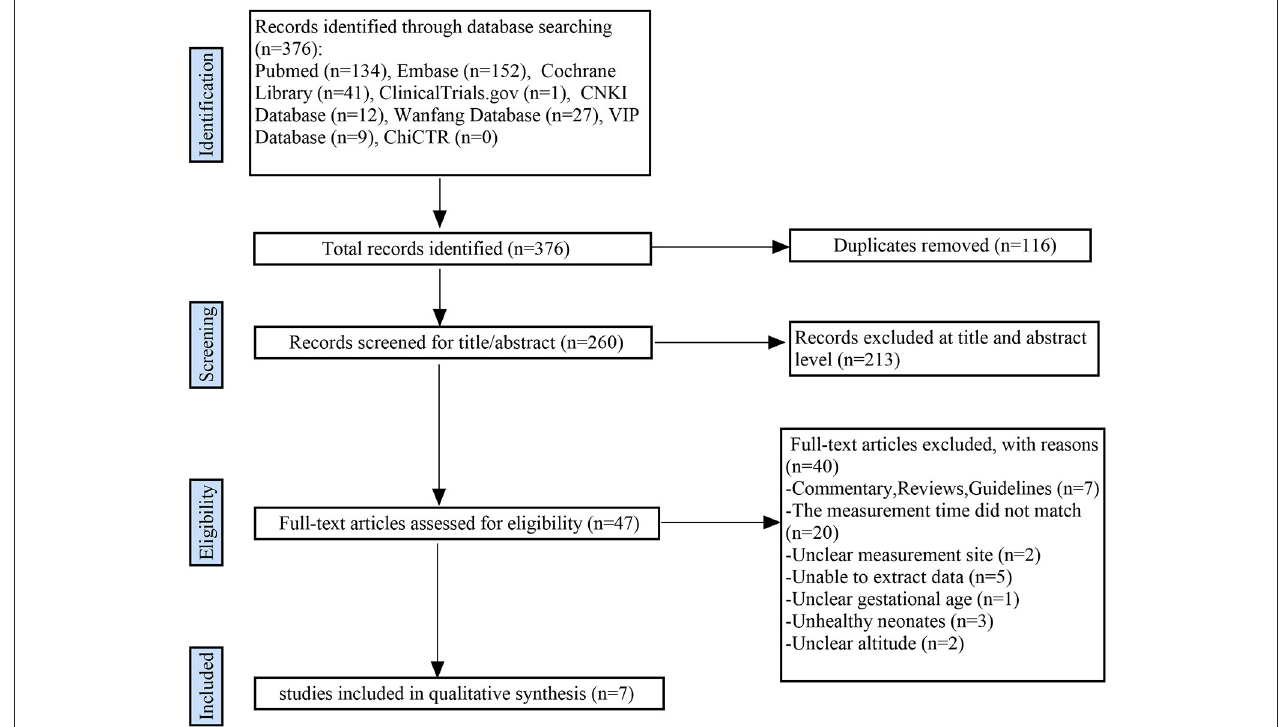
FIGURE 1 | Flow diagram showing study selection